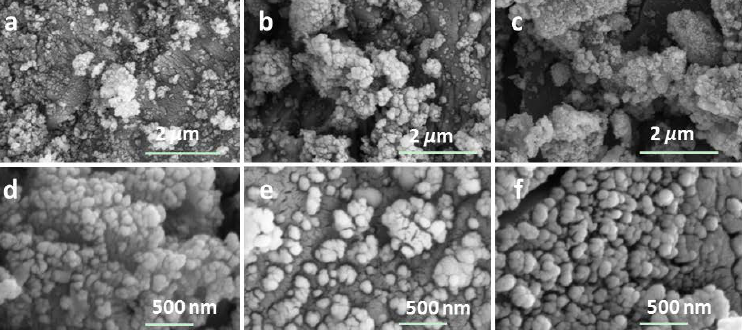
Figure 5. SEM images of the surface of marble ( a ), Hedishi ( b ), and Qingshi ( c ) treated with PDA